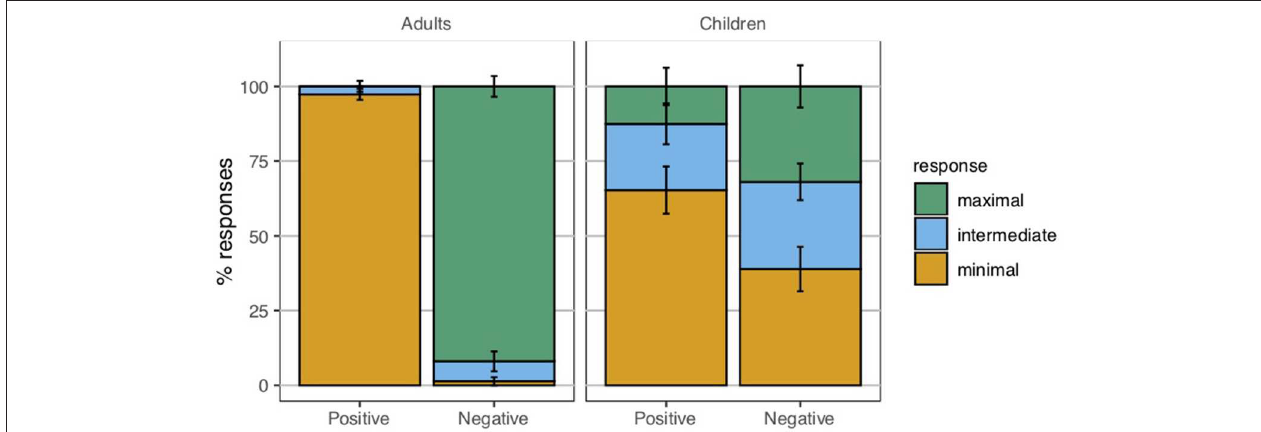
FIGURE 12 | Percentages of the reward types given in the universal tous “all” conditions. Positive universal descriptions of GAP contexts corresponded to partial truth controls; negative universal descriptions of GAP contexts corresponded to scope ambiguity controls. A greater-than-minimal reward for positive universal descriptions of GAP contexts was indicative of partial truth effects. A less-than-maximal reward for negative universal descriptions of GAP contexts was indicative of scope ambiguity